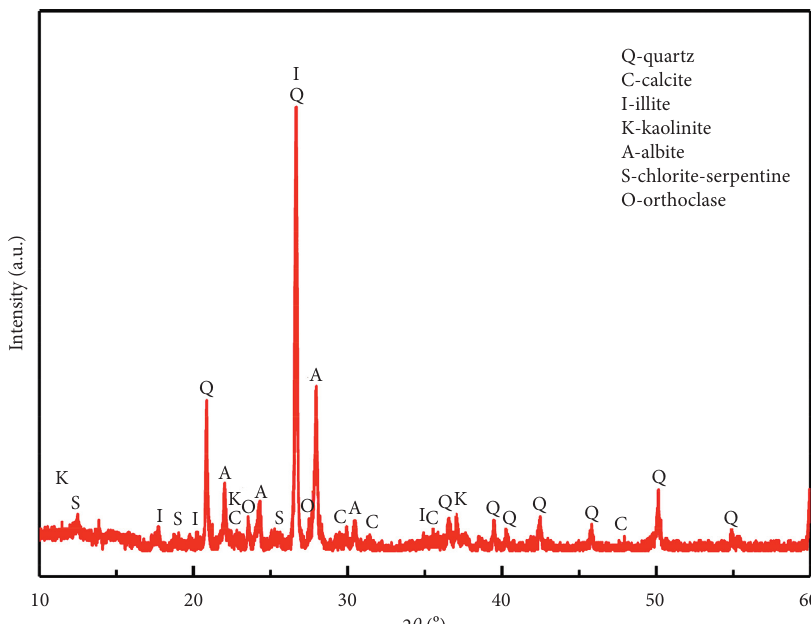
Figure 1: XRD results of the mineral components for the sandstone sample.